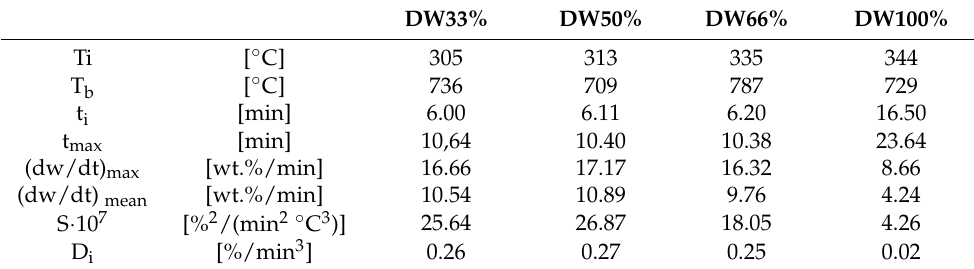
Table 5. Combustion characteristic parameters of the distillery waste char.